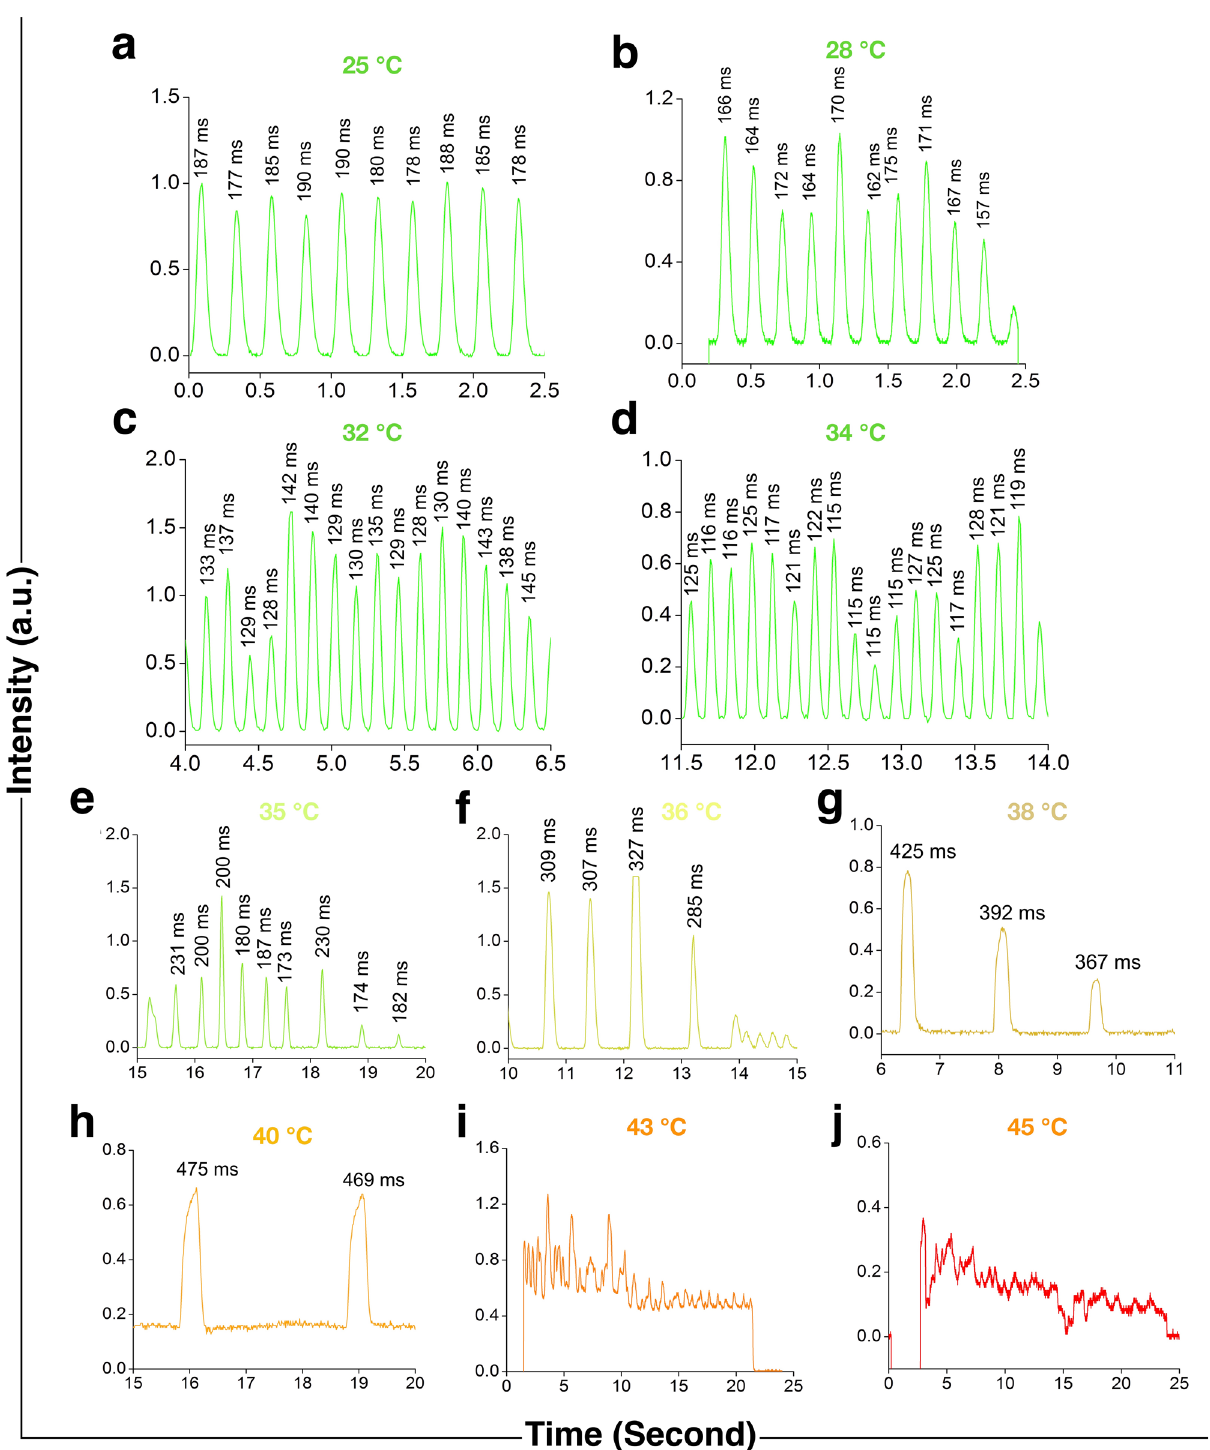
Figure 4. Flashes from the specimens of S. substriata at normal and high temperatures. ( a – d ) At 25, 28, 32, and 34 °C, the flash duration and the flash interval could be observed to decrease as the temperature increases. Regularity in the interval is sustained. ( e – h ) At 35, 36, 38 and 40 °C, the flash duration increases considerably with temperature which probably imply high temperature denaturation of the enzyme luciferase. The flash duration is somewhat uniform. Distortions slowly begin to manifest in the flashes from 38 °C upwards. The duration of a flash is indicated near its peak in this figure, ( a – h ). ( i , j ) At 43 and 45 °C, pulses are no longer single; these become combination ones and